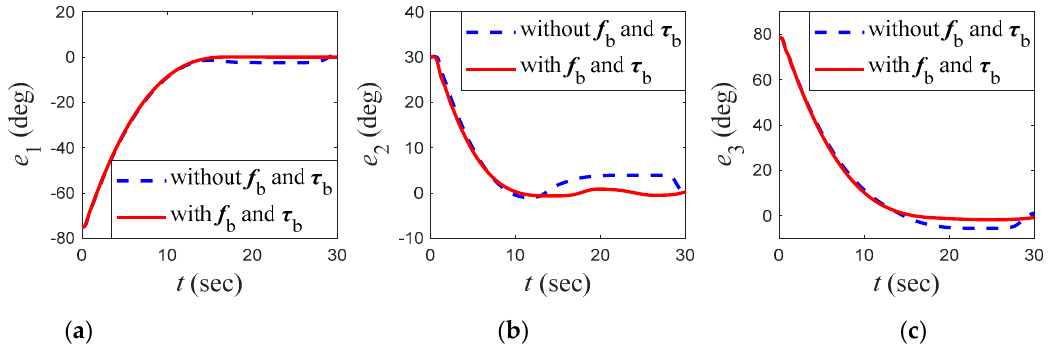
Figure 18. Comparison of angle tracking errors with and without platform control. ( a ) The first value of the angle tracking error; ( b ) The second value of the angle tracking error; ( c ) The third value of the angle tracking error.